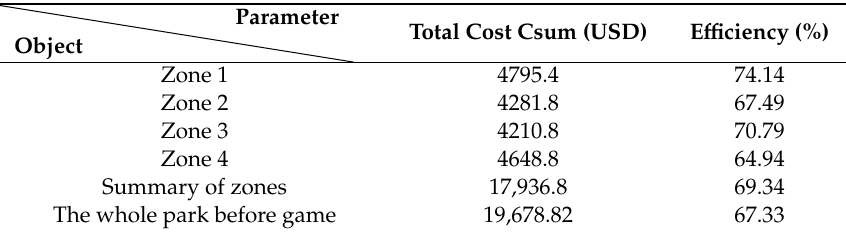
Figure 7. Comparison of gas purchase and electricity purchase of the park before and after the game. ( a ) Comparison of gas purchase. ( b ) Comparison of electricity purchase. According to the proposed model and solution method, the daily total cost and the energy efficiency of CHP system of each zone are calculated respectively. The results are compared with those of the whole integrated energy park before the game, as shown in Table 3. The summary cost of the zones is the total cost of the four zones costs, the summary efficiency of the zones is the average efficiency of the four zones. Table 3. Comparison of cost and energy efficiency of combined heat and power (CHP) system in the park before and after the game.